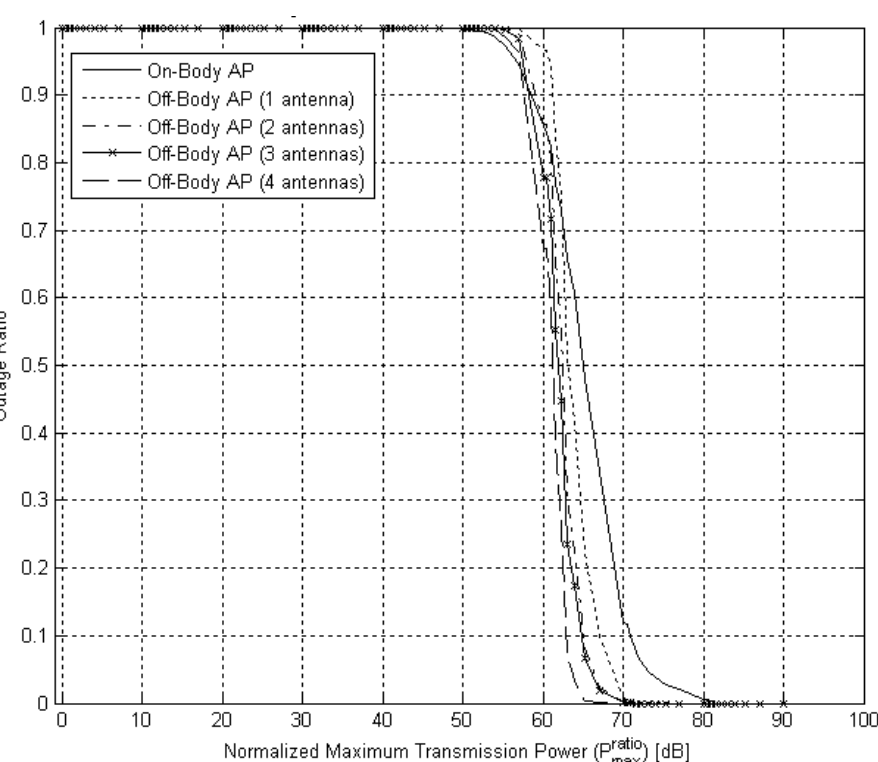
Figure 13. Network connectivity outage ratio as a function of normalized maximum transmission power. Note the threshold effect, where beyond a normalized power level the network is almost always